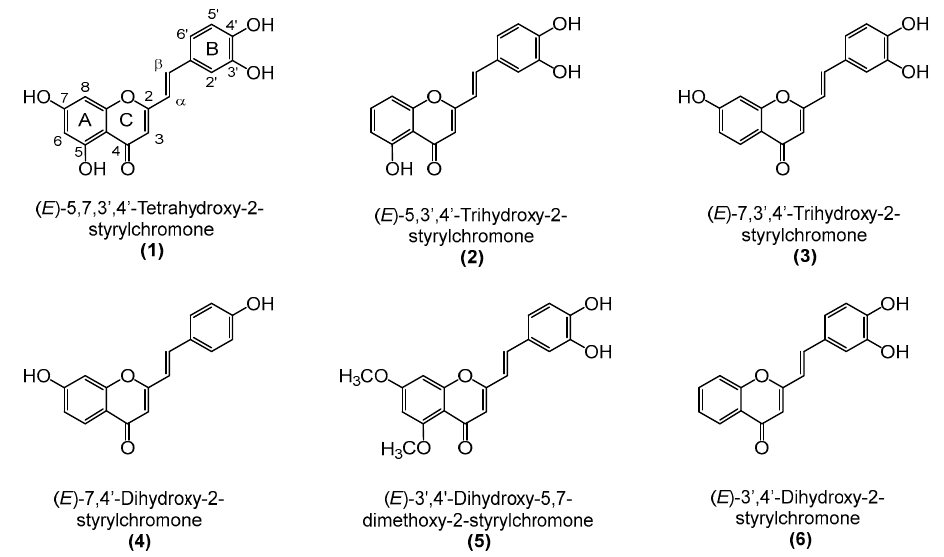
Figure 1. Chemical structures of the tested 2-styrylchromones (2-SC) ( 1 – 6 ).